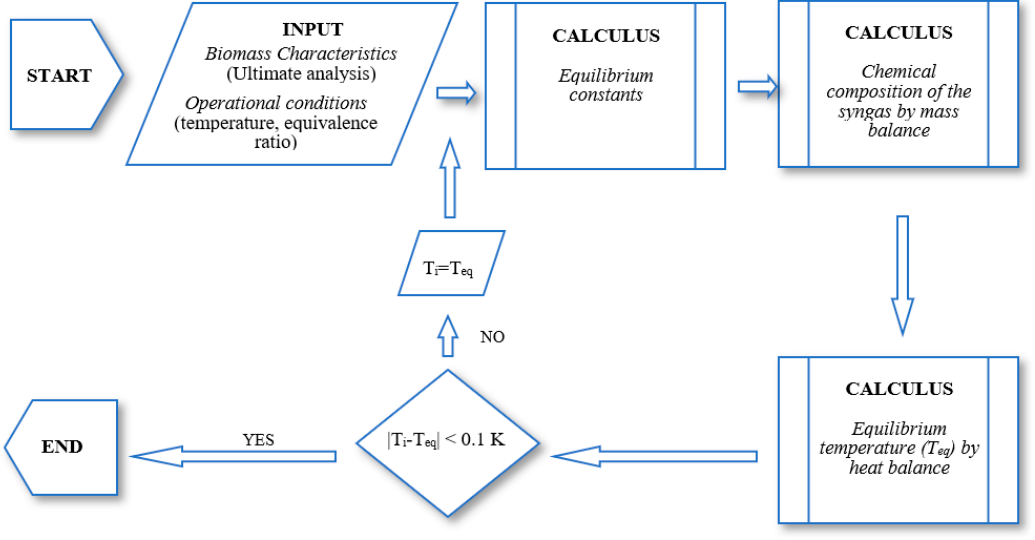
Figure 2. General flowchart of a stoichiometric model.